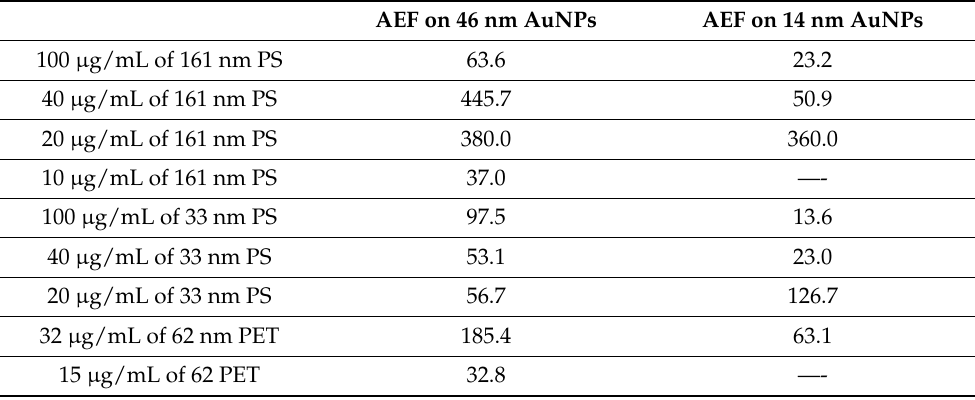
Table 2. A summary of analytical enhancement factors (AEFs) calculated for each sample.